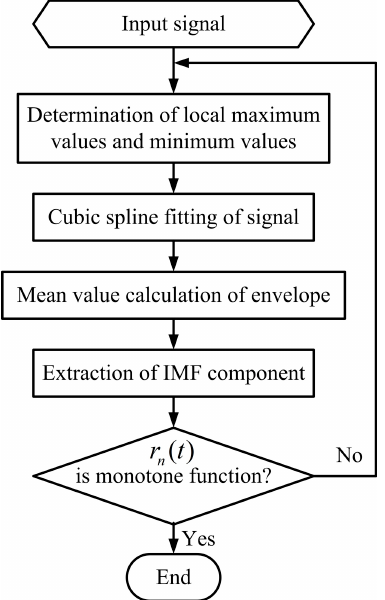
Figure 4. EMD flow chart.